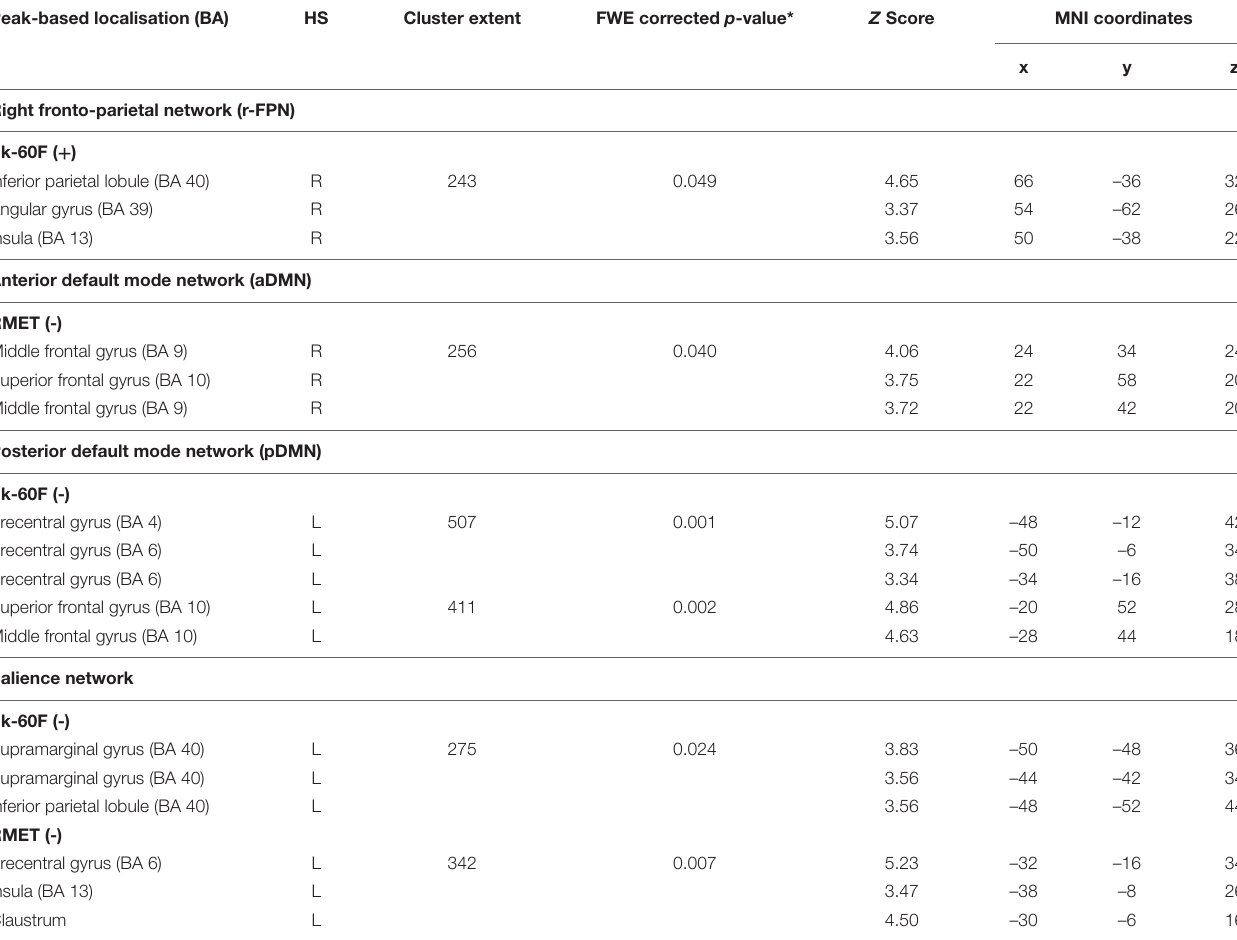
TABLE 6 | Clusters of significant correlation between social cognition scores and functional connectivity of the aDMN, r-FPN and salience network. Peak-based localisation (BA) HS Cluster extent FWE corrected p -value* Z Score MNI